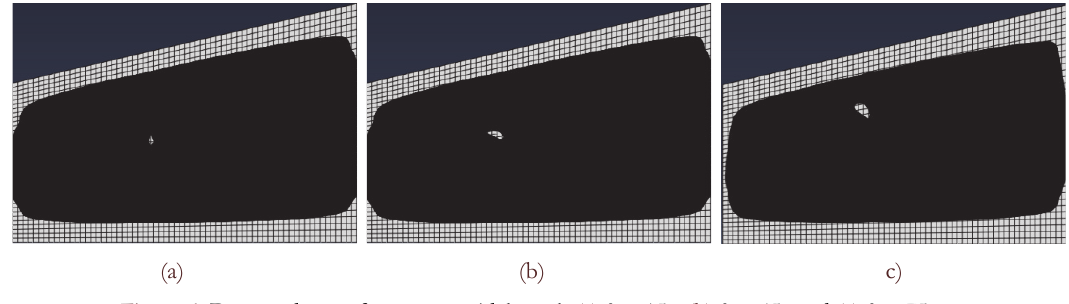
Figure 6: Damaged zone for a trapezoidal patch (a) θ = 15 o , (b) θ = 45 o and (c) θ = 75 o